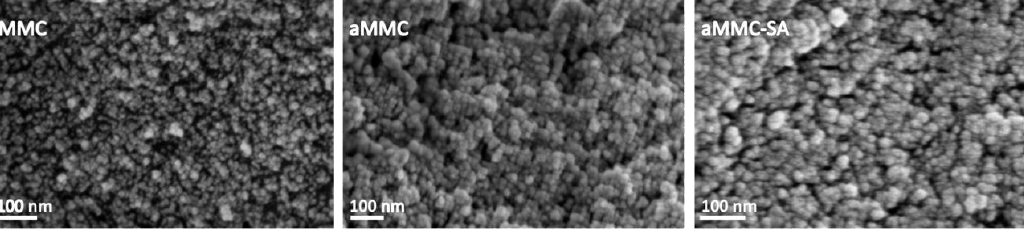
Figure 5. SEM images of MMC, aMMC, and aMMC-SA.